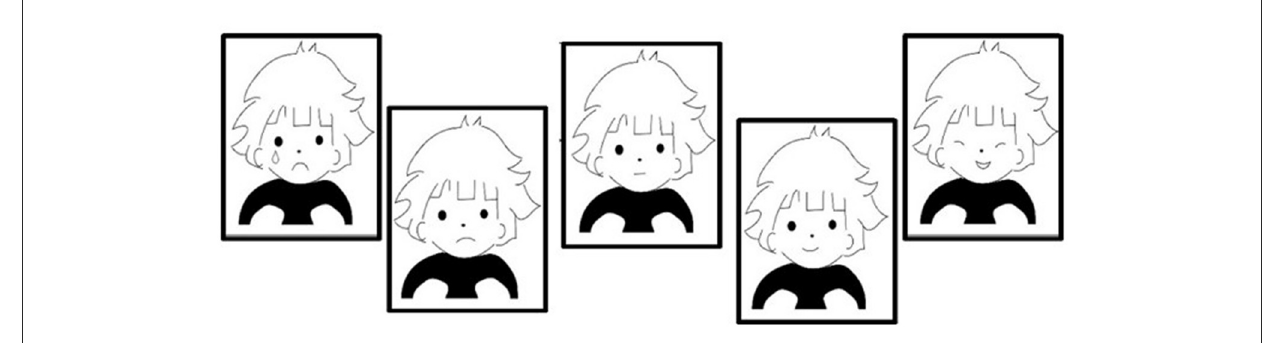
FIGURE1 Images for response options of the AUQEI.